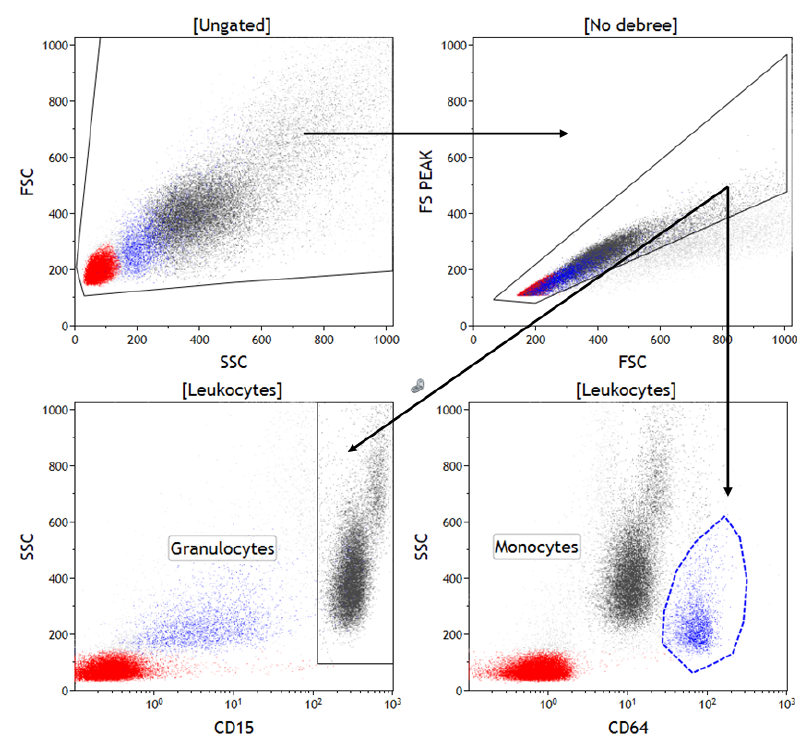
Figure 1. Gating strategy for granulocytes and monocytes Legend . Gating strategy: Obtained events were gated in an FSC intensity and SSC intensity dot plot to eliminate debris. Cells were gated on an FSC intensity and FSC peak dot plot to eliminate doublets. Granulocytes were gated on an SSC vs. CD15 dot plot. Monocytes were gated on an SSC vs. CD64 dot plot. The expression level of selected markers is evaluated as fluorescence intensity on the histograms. FSC: Forward scatter, SSC: Side scatter.